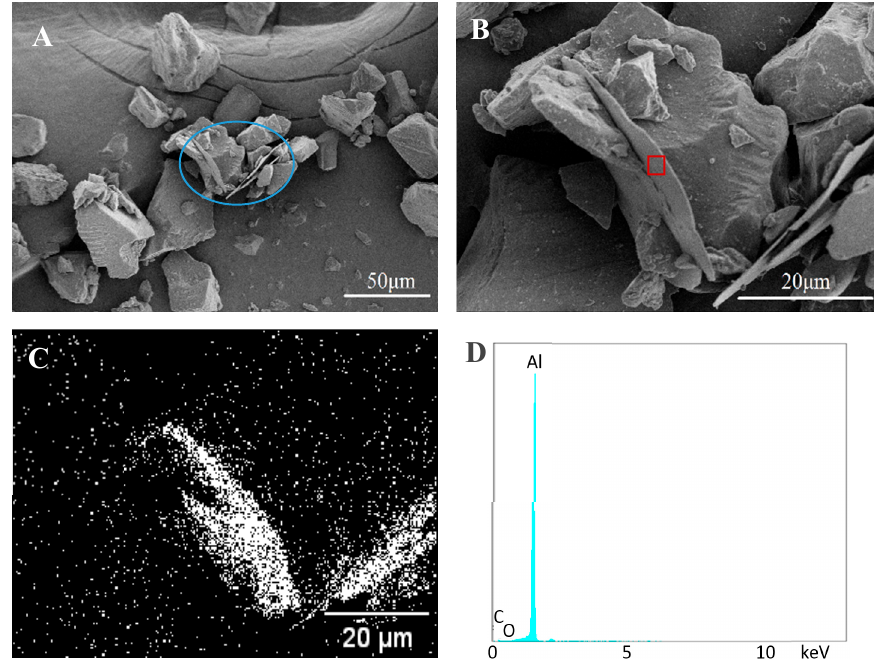
Figure 9. SEM and EDS images of bonded samples. ( A , B ) SEM images of cold bonded sample by PVA; ( C ) EDS scanning of aluminum element; ( D ) EDS spectrum of the rectangle area in ( B ).